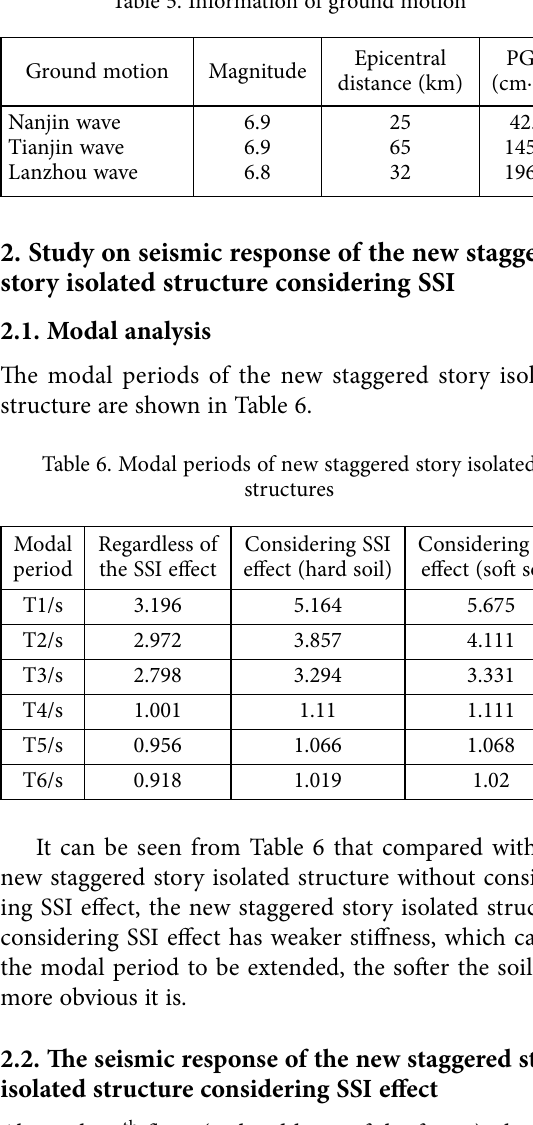
Figure 8. Acceleration spectra of selected ground motion Table 5. Information of ground motion